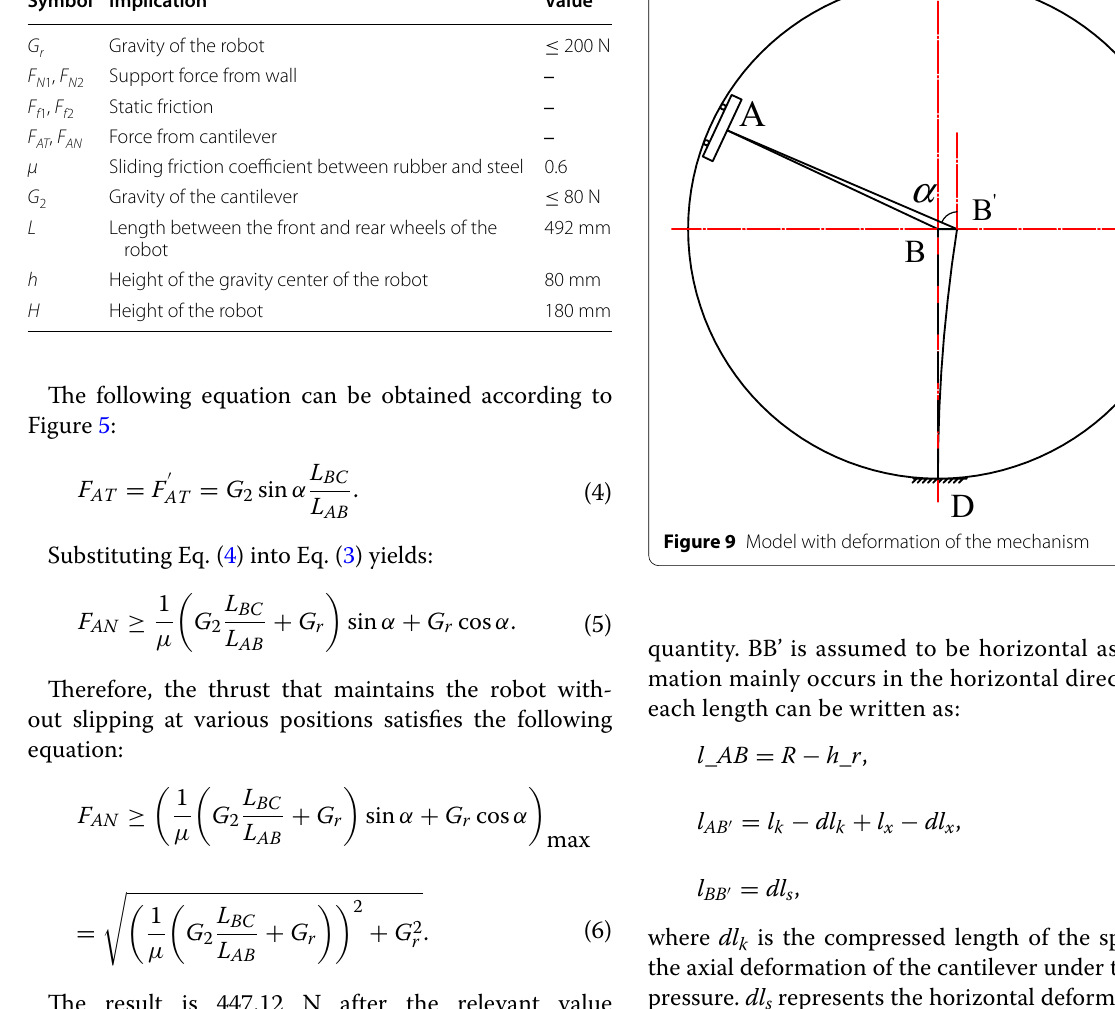
Table 2 Parameters of force analysis Symbol Implication